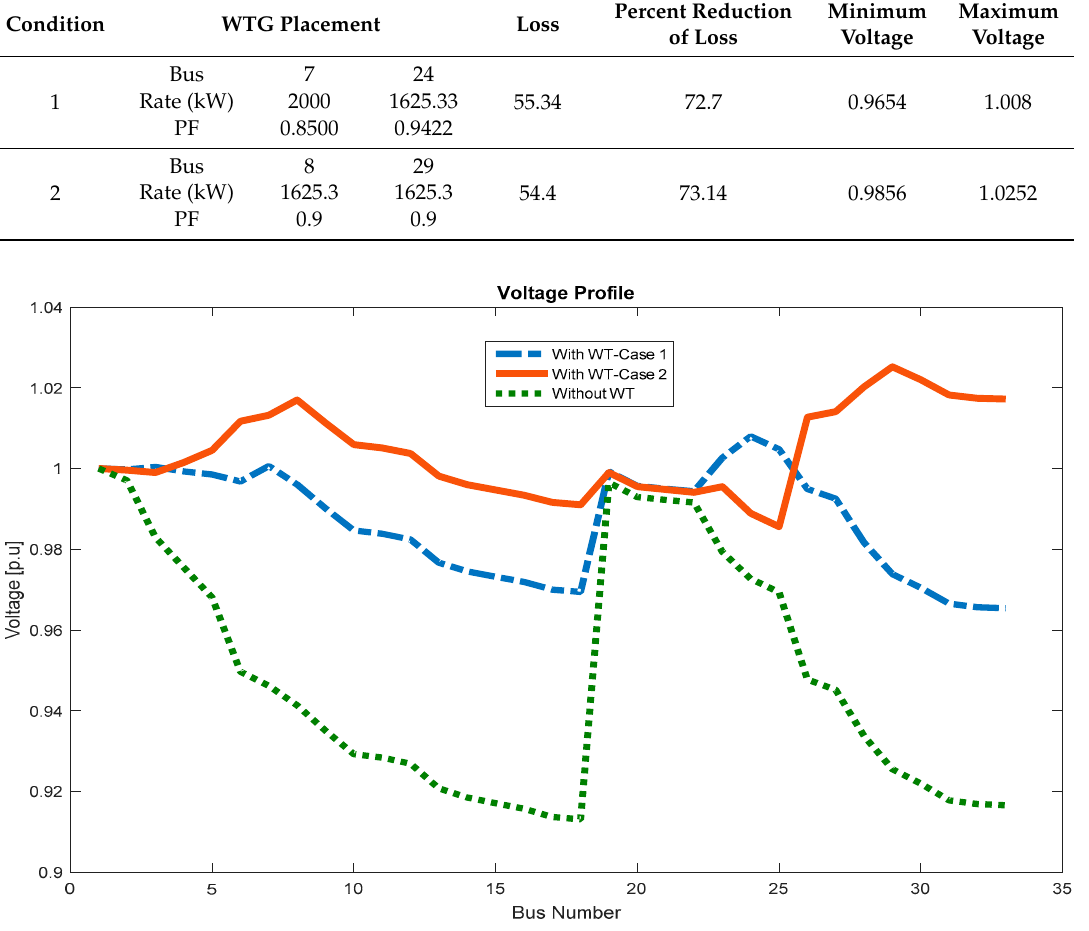
Figure 8. 32-bus grid voltage profile before and after installing the turbines with respect to constraints.